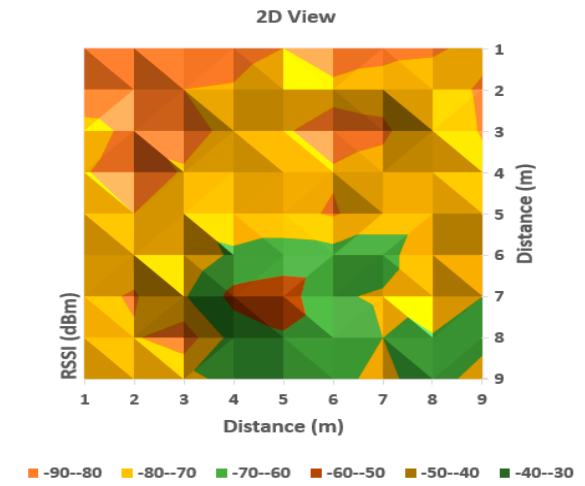
Figure 6. A two-dimensional representation of signal variation with different coloring according to RSSI measured values (Measurement point: MeS 1 ).